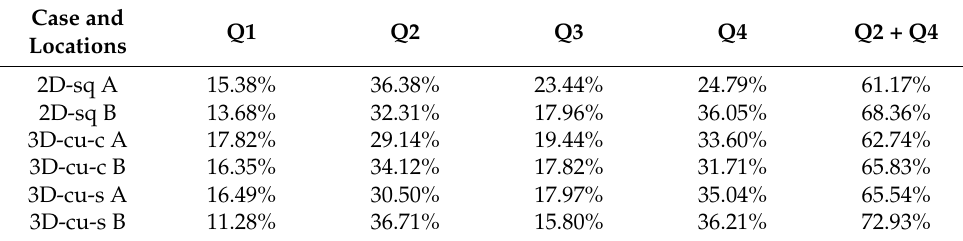
Figure 11. Quadrant analysis of velocity fluctuations for 2D-sq, ( a ) type A, ( b ) type B. The contour represents the joint probability density function of velocity fluctuations u’ and v’ . Hyperbolas represent the average shear stress isoline of each type of location, respectively. The dashed line represents the major axis of the elliptic cloud formed by the scattered points. Table 3. Proportions of shear stress fluctuations in each quadrant.